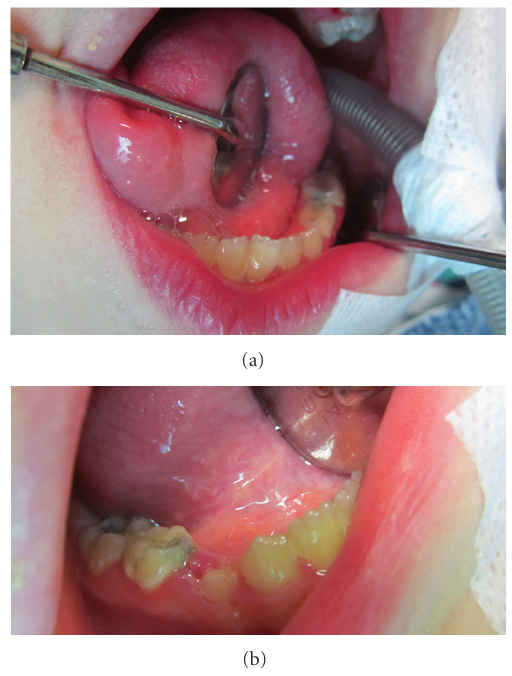
Figure 5: Lower molar teeth had deep dentinal carious